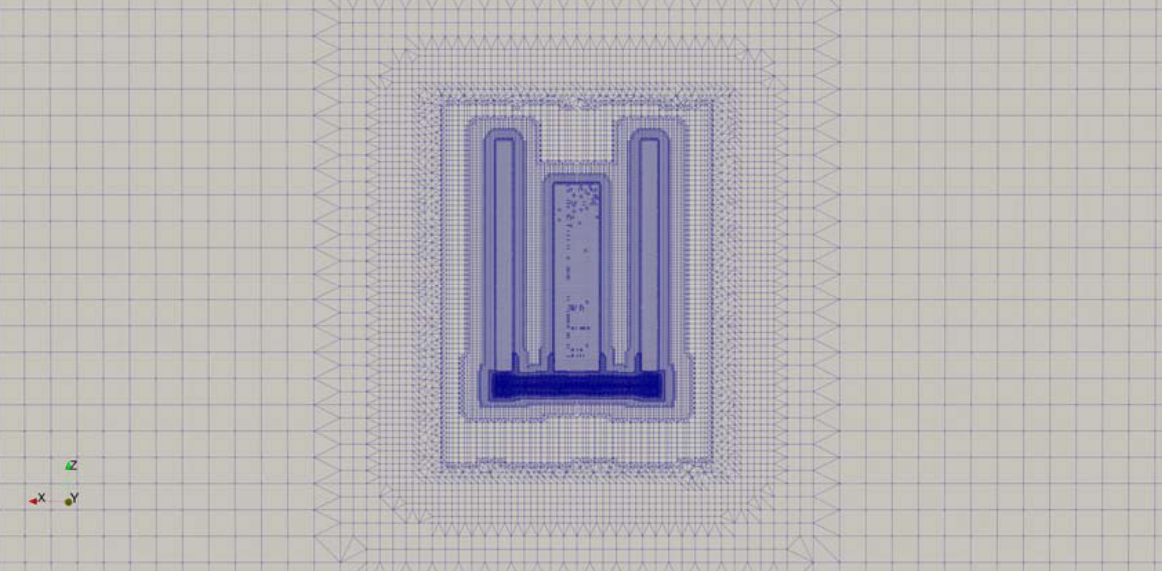
Figure 8. AMI (rotating) zone of the wind turbine.